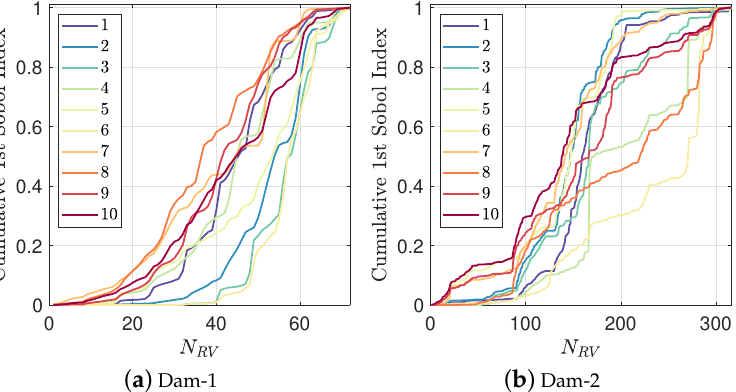
Figure 14. Spectrum of cumulative first order Sobol indices along number of random variables, N RV , for various